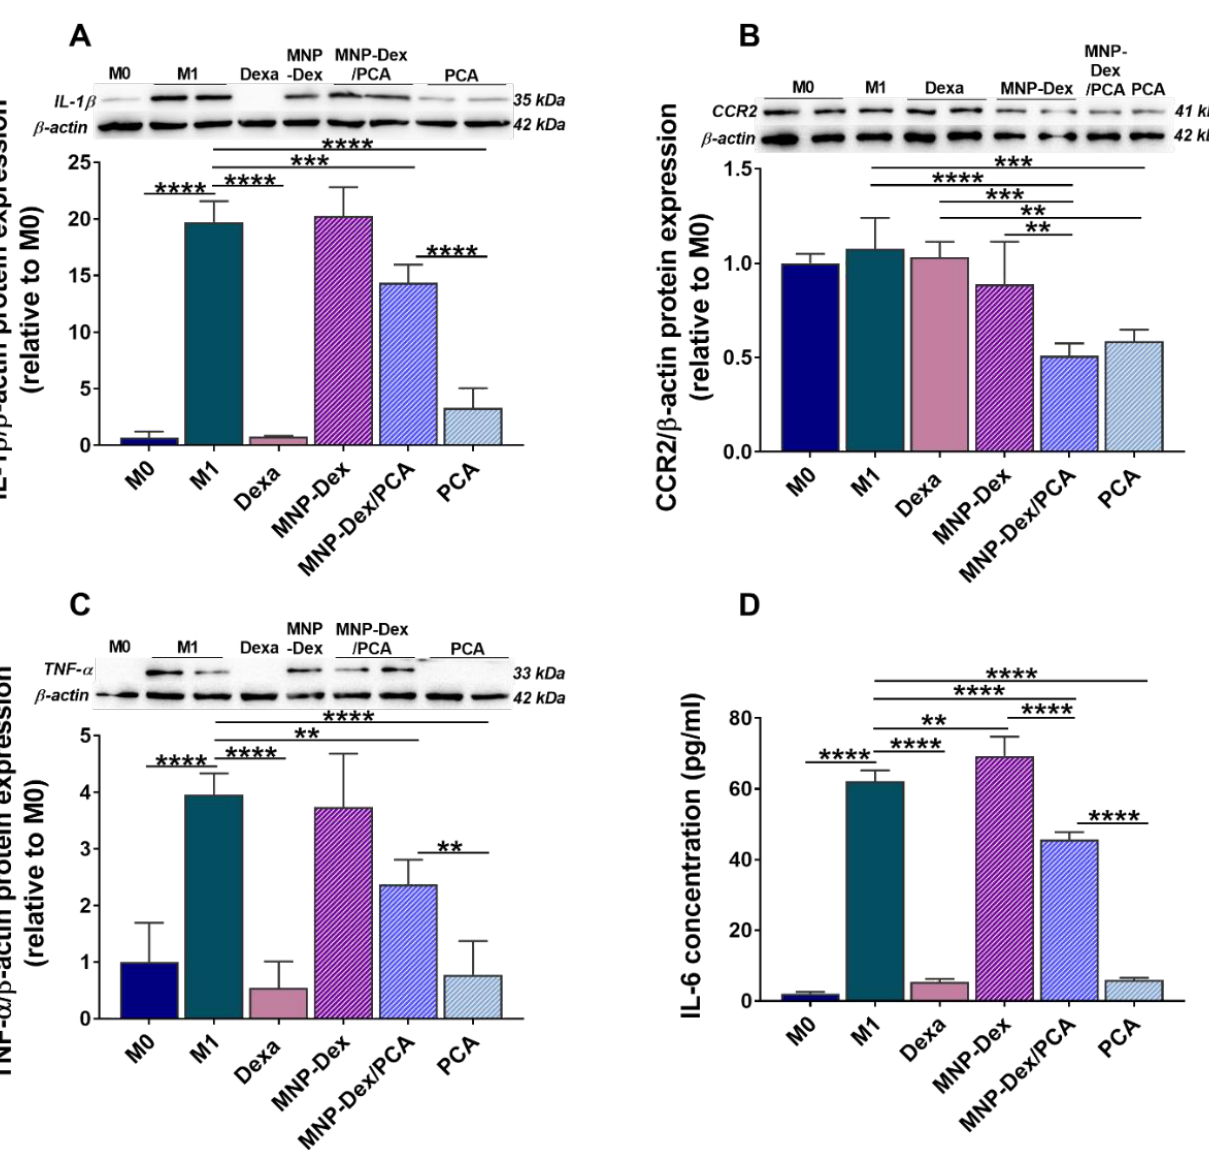
Figure 5. The anti-inflammatory effect of MNP-Dex/PCA on THP-1-derived M1 macrophages was determined by evaluating the expression of intracellular pro-inflammatory molecules IL-1 β ( A ), CCR2 ( B ), TNF- α ( C ), and the levels of released IL-6 ( D ) after 48 h of treatment. Protein expression was normalized to β -actin. For comparison, the levels of pro-inflammatory molecules in M0 macrophages were shown. The data are expressed as mean ± SD from at least three independent experiments performed in duplicates. ** p < 0.01, *** p < 0.001, and **** p < 0.0001. The protein levels of cytokines in M0 macrophages are also shown. Dexa-treatment of M1 macrophages with dexamethasone (2.5 µM).